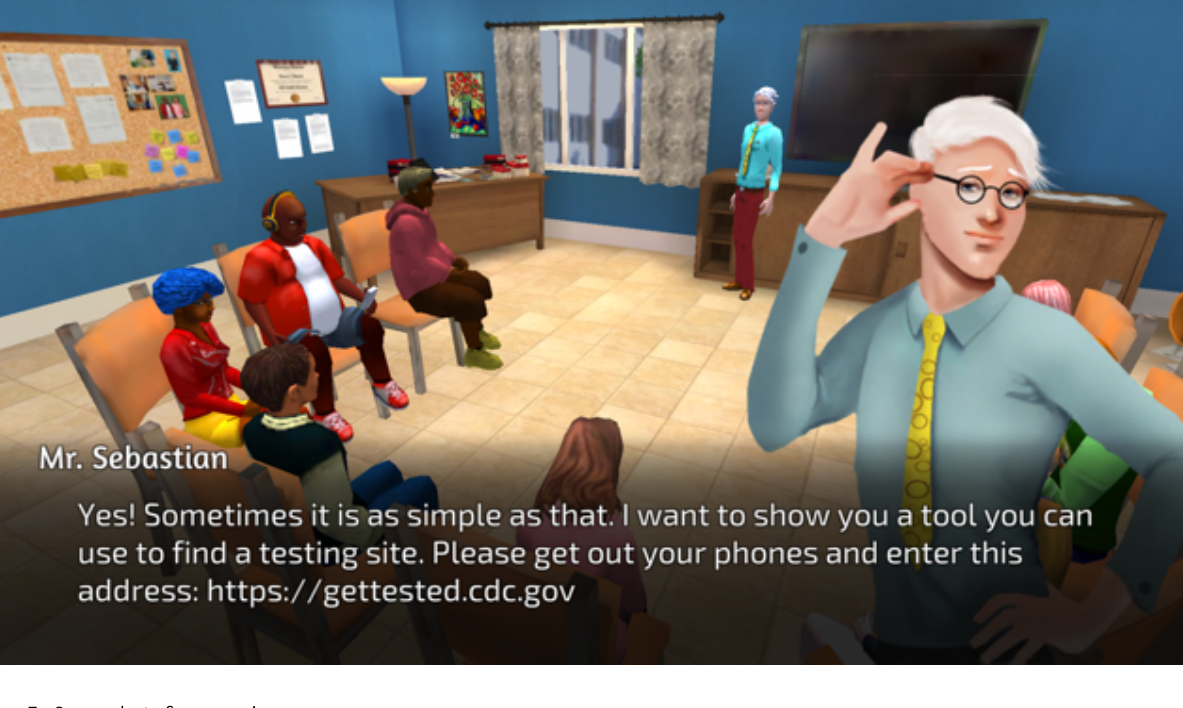
Figure 7. Screenshot of a pop